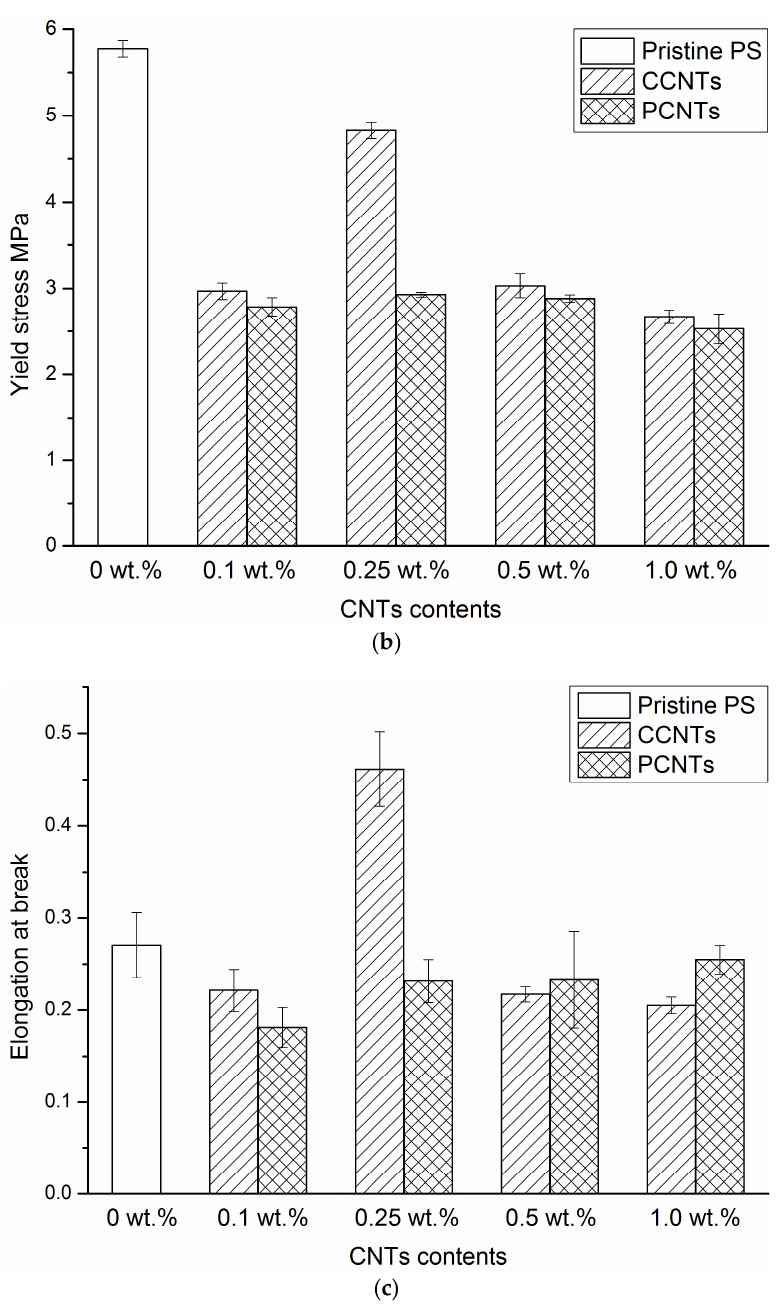
Figure 6. Young’s modulus ( a ), yield stress ( b ), and elongation at break ( c ) of PS nanocomposite membranes with different contents of CCNTs and PCNTs at room temperature at an initial strain rate of 0.17/s.